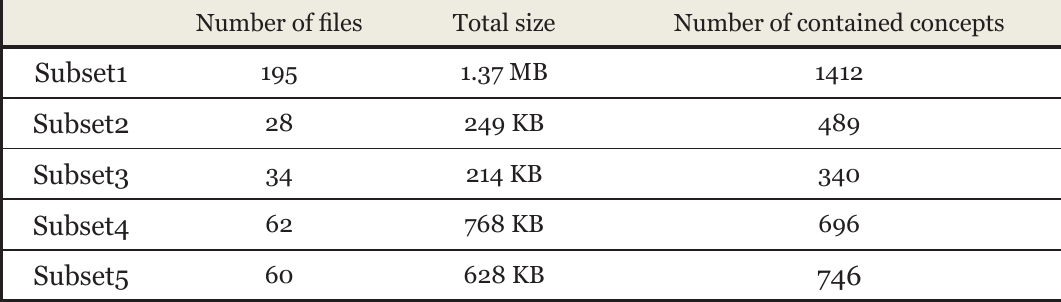
Description of Test Document